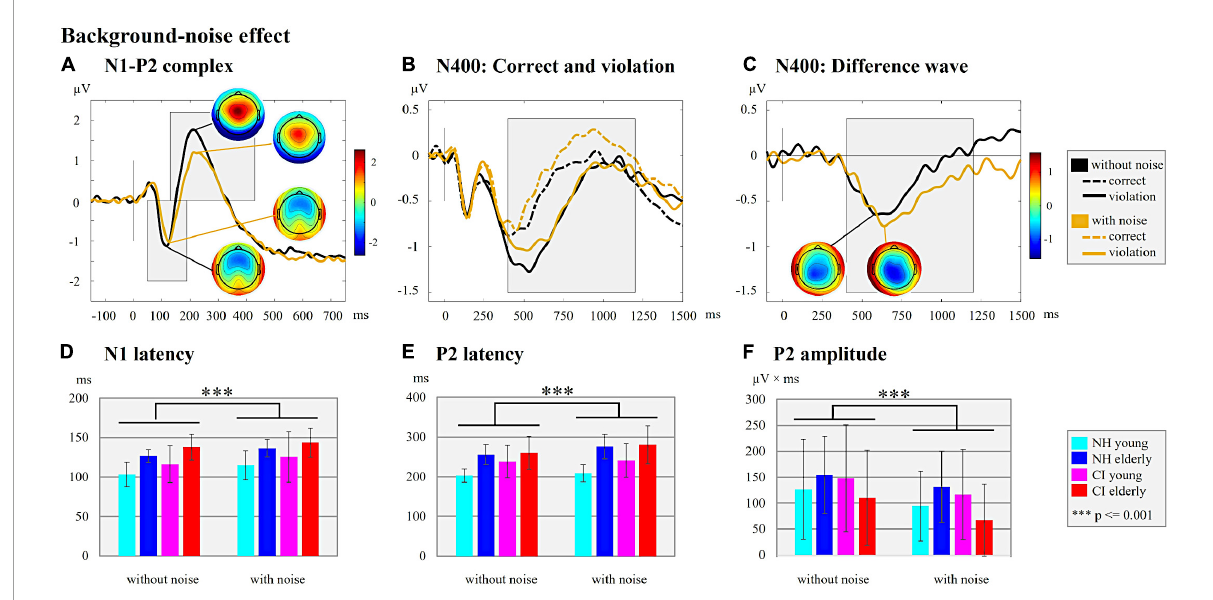
FIGURE4 Background-noise effect. (A) N1-P2 complex. ERPs are shown for the hearing condition with and without background noise independent of the hearing group (NH/CI) and the age (young/elderly). The ERP topographies at the N1 (without background noise: 116 ms; with background noise: 124 ms) and P2 peaks (without background noise: 210 ms; with background noise: 214 ms) are given separately for each hearing condition (with/without background noise). Gray-shaded boxes indicate the N1 and P2 time windows for peak and latency detection. (B) N400: Correct and violation. ERPs are shown for the two hearing conditions with and without background noise independent of the factors hearing and age but separately for the different semantic context of the sentences (semantically correct vs. semantically incorrect/violation). The gray-shaded box indicates the N400 time window for the peak and latency detection of the supplementary analyses. (C) N400: Difference wave. The difference waves of the N400 ERP are shown for each hearing condition (with/without background noise) independent of the hearing groups and age groups. The ERP topographies at the N400 peaks are shown for both hearing conditions (without background noise: 588 ms; with background noise 638 ms). The Gray-shaded box indicates the N400 time window for the peak and latency detection. (D) N1 latency. Bar plots with mean N1 latency (ms) for each subgroup separately for the hearing condition with and without background noise. (E) P2 latency. Bar plots with mean P2 latency (ms) for the comparison between each subgroup separately for the hearing condition with and without background noise are shown. (F) P2 amplitude. Bar plots with mean P2 amplitude area ( µ V × ms) for each subgroup separately for each hearing condition (with/without background noise) are shown.